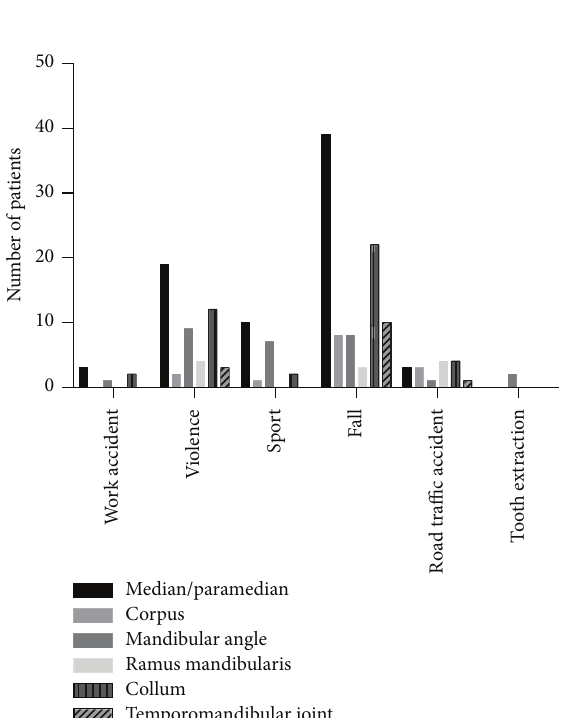
Figure 5: (a) Number of fractures by sex. (b) Average number of fractures by cause.